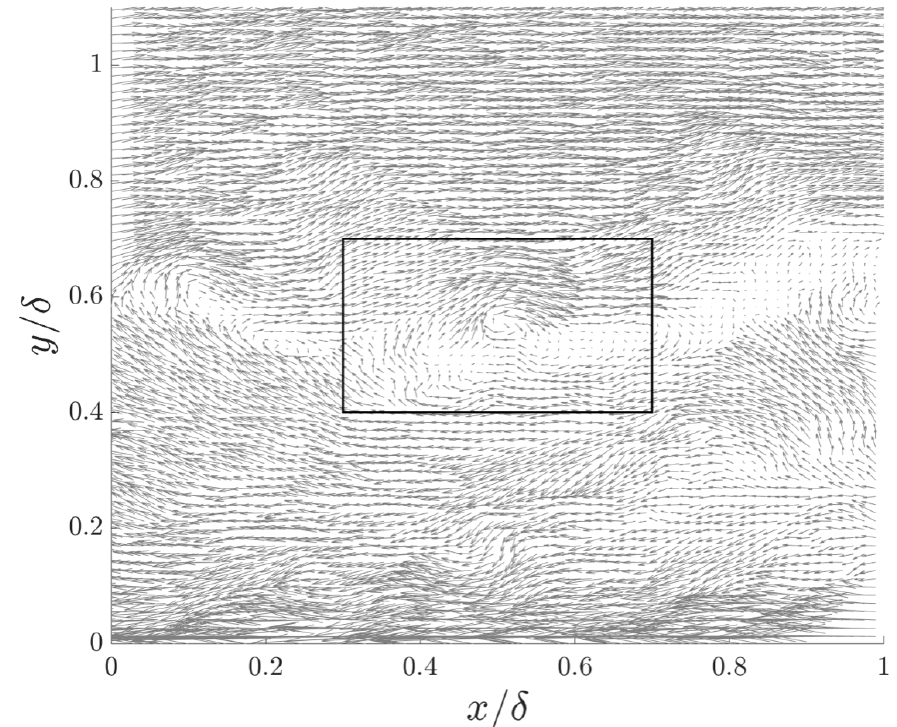
Figure 2. The velocity vector field in a frame-of-reference convecting at U c = 0.83 U ∞ . The rectangle highlights the identified vortex in the